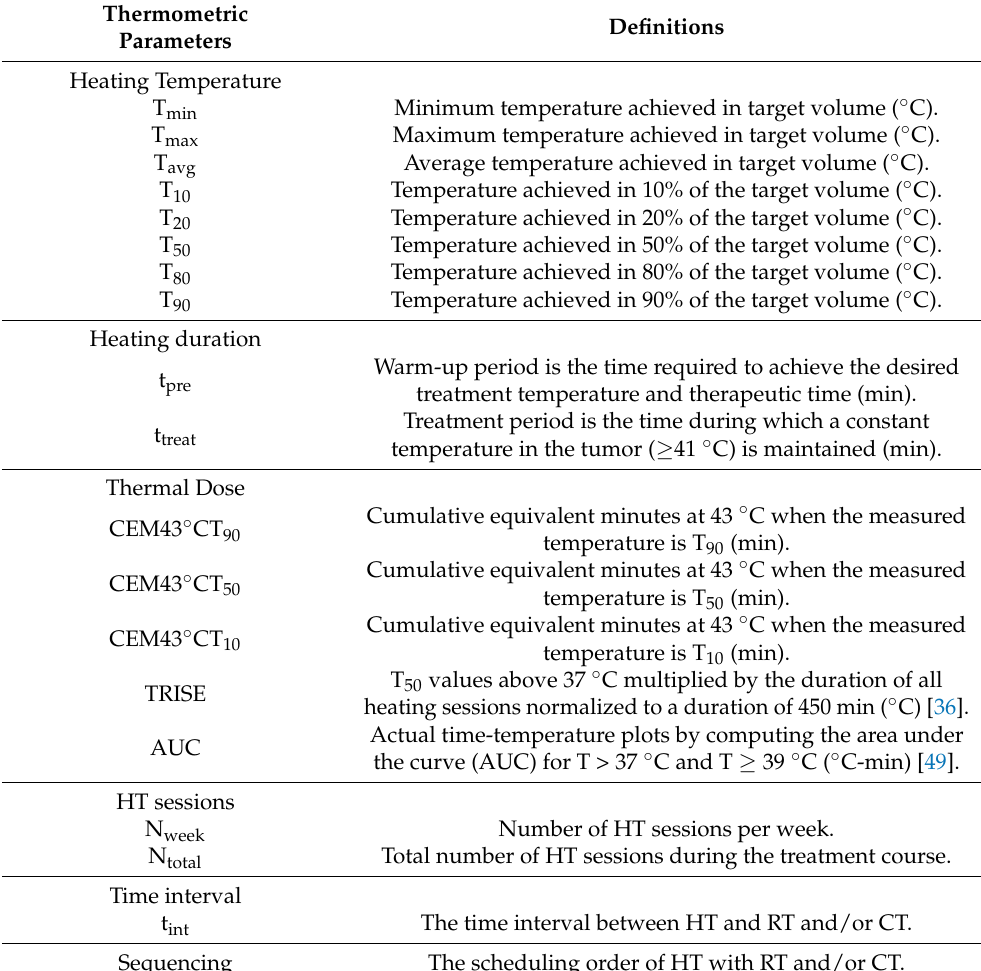
Table 1. Definition of thermometric